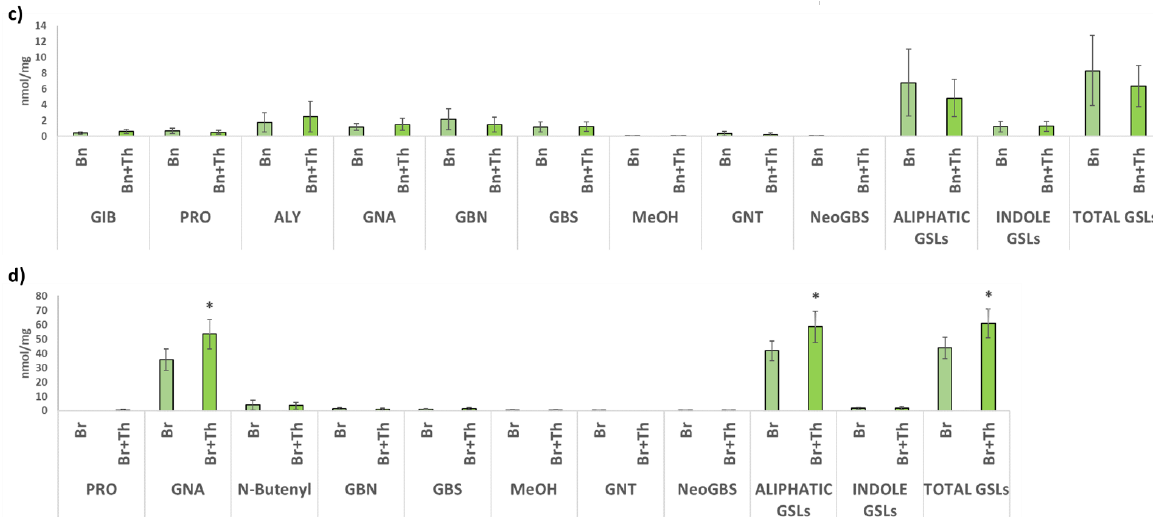
Figure 2. GSLs contents in leaves from kale (Boa) ( a ), cabbage (Boc) ( b ), leafy rape (Bn) ( c ) and leafy turnip (Br) ( d ) without inoculation and inoculated with T. hamatum (+Th). GIB: glucoiberin, SIN: sinigrin, PRO: progoitrin, ALY: glucoalyssin, GNA: gluconapin, GBS: glucobrassicin, MeOH: metoxy-glucobrassicin, NeoGBS: neoglucobrassicin, GNT: gluconasturtiin. Data are the mean of 10 plants for each crop and condition with the corresponding standard deviation. Student’s t -test was performed between uninoculated and Trichoderma -inoculated plants for each GSL. Asterisks denote significant differences at p ≤ 0.05 (*).